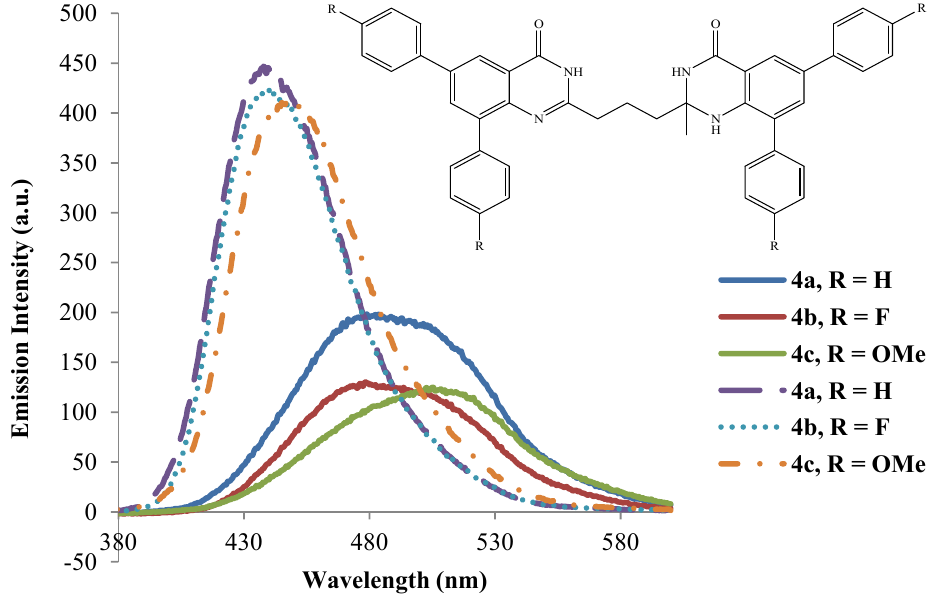
= 270 nm) in DMSO (dashed lines) and CH ex